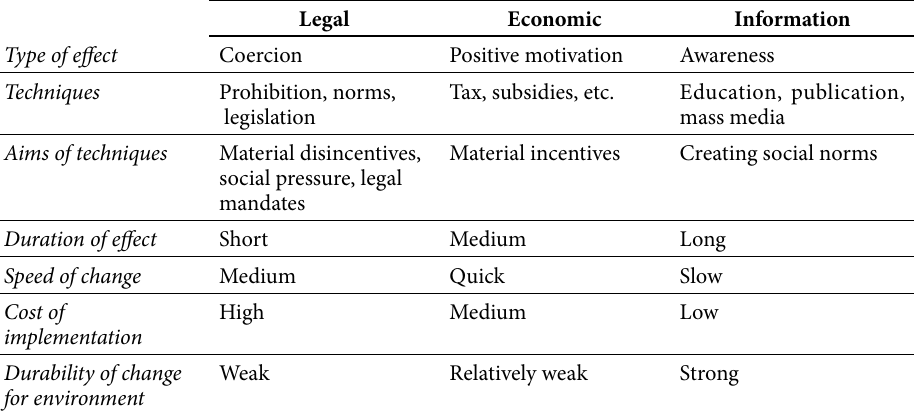
Fig. 3. Selection of legal, economic and information tools to change sustainable/environmental